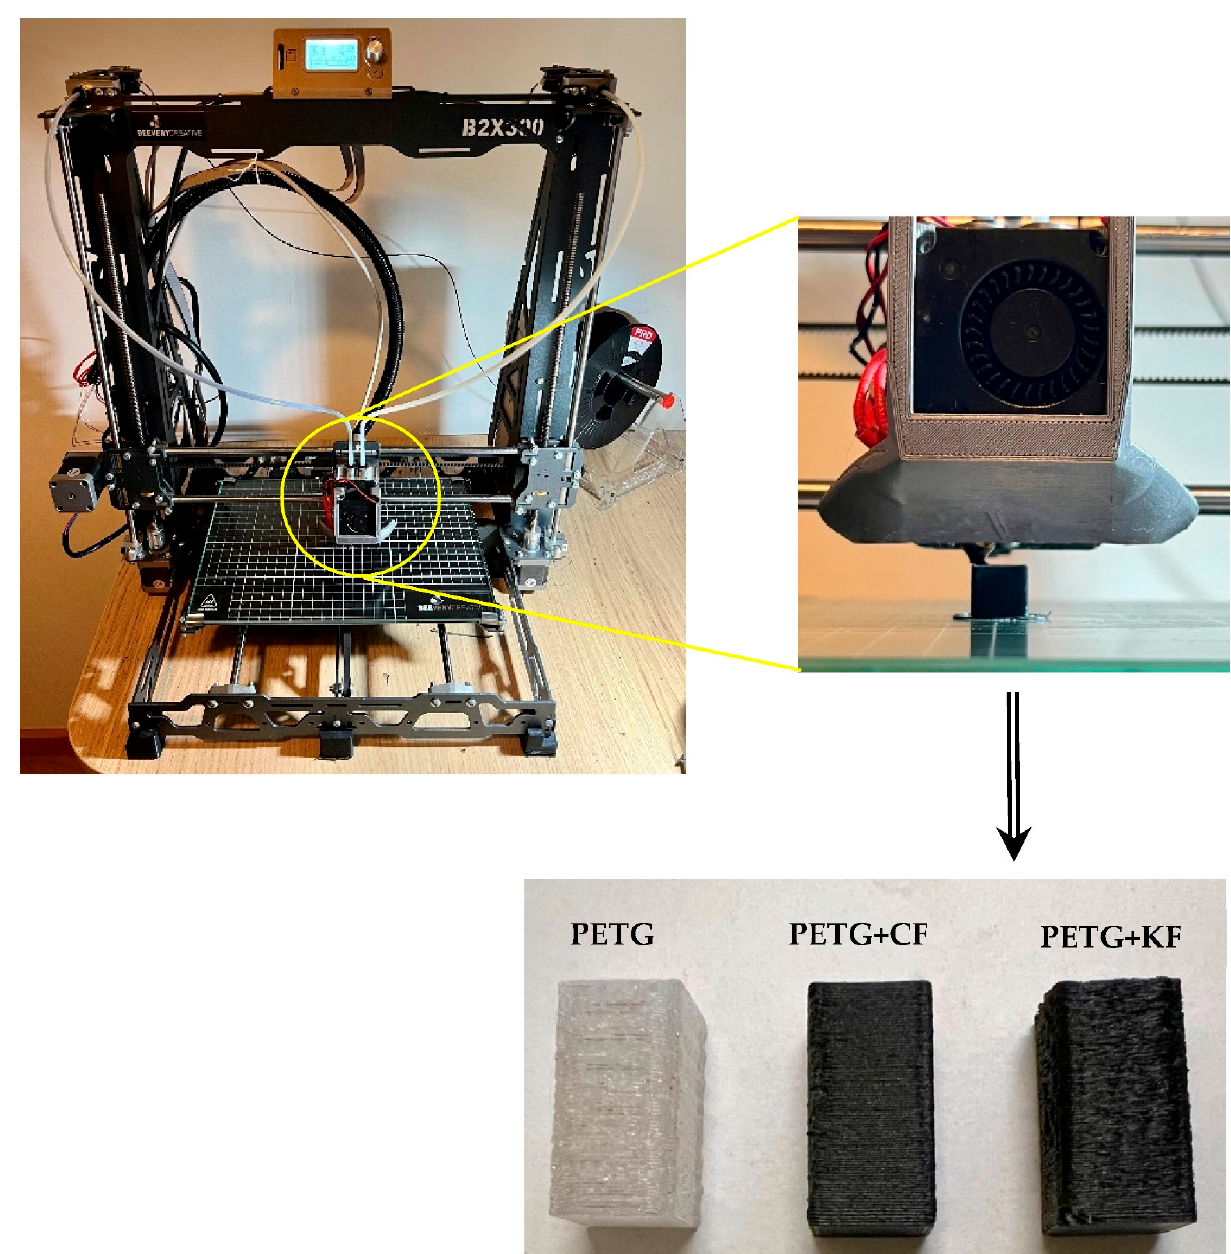
Figure 1. Details of the 3D printer producing a specimen in an environmentally controlled room.